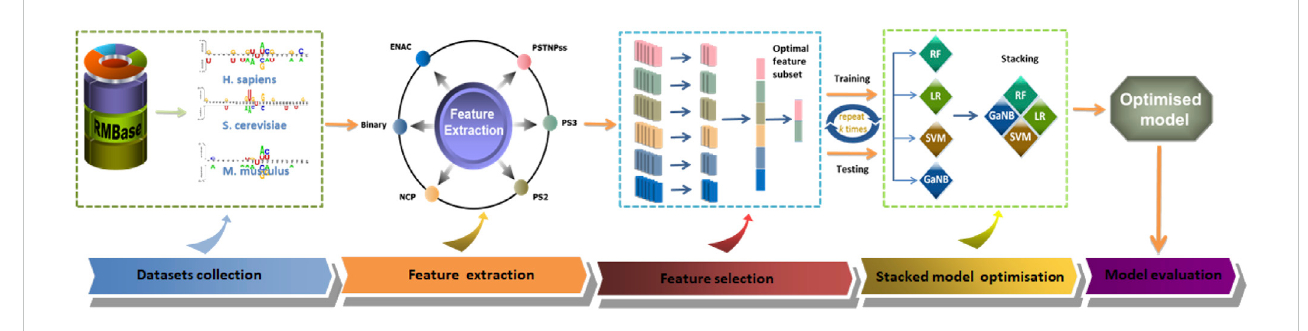
FIGURE 1 The overall framework of PseU-ST. There are fi ve major steps, including dataset collection, feature extraction, feature selection, stacked model optimisation, and model evaluation.